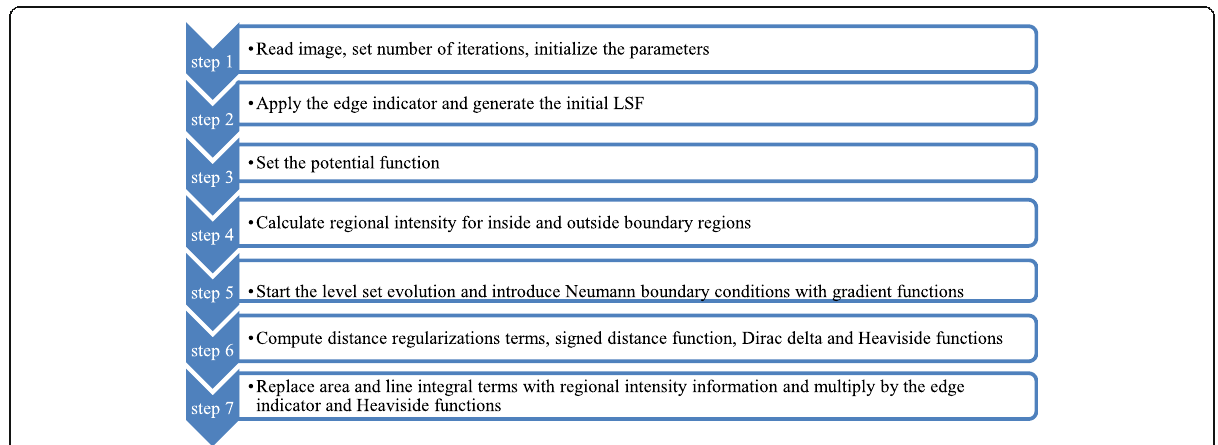
Fig. 5 Flow chart explaining the numerical implementation of the proposed